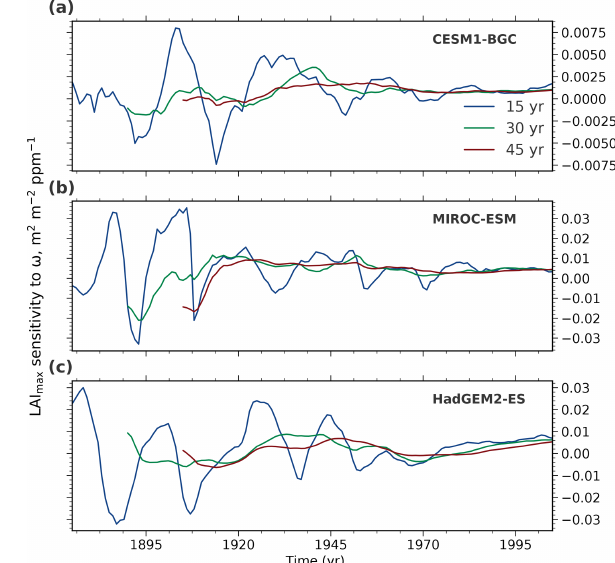
Figure 4. Temporal variation of LAI max sensitivity to ω in three selected CMIP5 models spanning the full range from low-end (CESM1-BGC, a ), to closest to observations (MIROC-ESM, b ), to high-end (HadGEM2-ES, c ). The colored lines show LAI max sen- sitivity variations for moving windows of varying length: 15 (blue), 30 (green), and 45 (red) years over the historical period from 1860 to